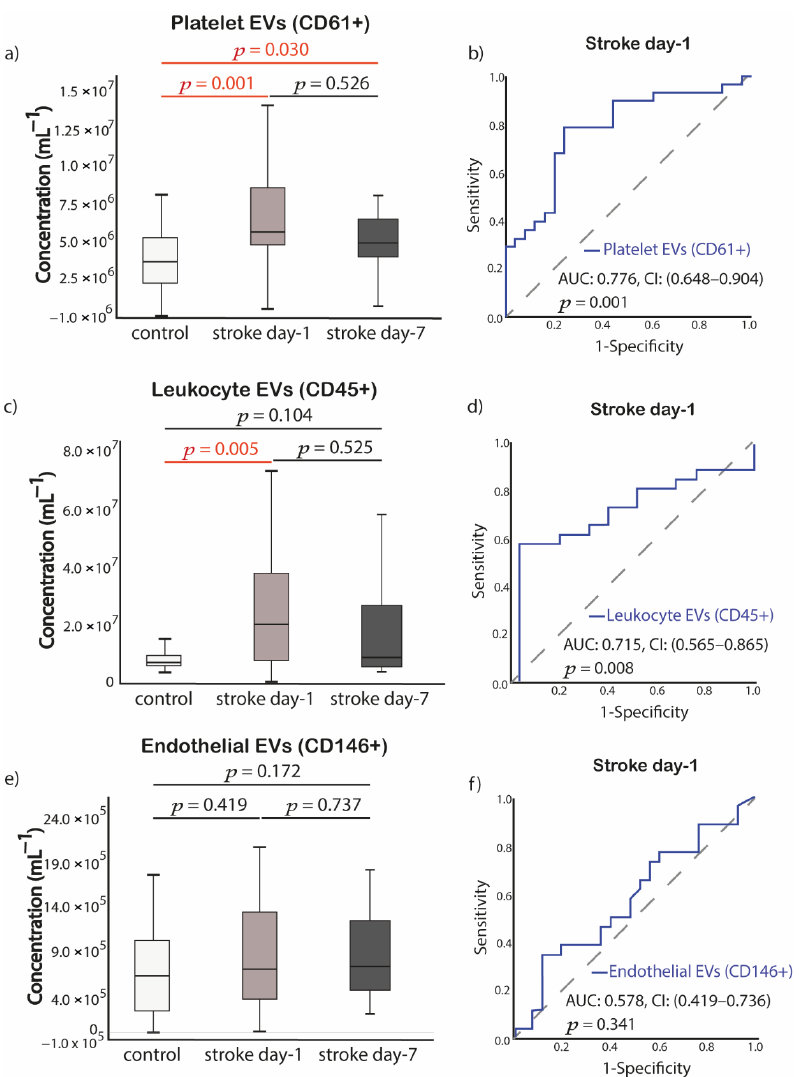
Figure 5. Alterations of EVs concentrations among the groups and diagnostic value of EVs determined by ROC curve analysis. ( a ) Platelet-EVs (CD61+); ( b ) ROC analysis of platelet-EVs (CD61+) from stroke day-1; ( c ) Leukocyte-EVs (CD45+); ( d ) ROC analysis of leukocyte-EVs (CD45+) from stroke day-1; ( e ) Endothelial EVs (CD146+); ( f ) ROC analysis of endothelial EVs (CD146+) from stroke day-1. p value was calculated with Mann-Whitney U or Wilcoxon test, appropriately (Control samples n = 35, acute stroke day-1 samples n = 28 and stroke day-7 samples n = 20). Abbreviations: EVs, extracellular vesicles; p , value; AUC, area under the curve; CI, confidence interval; ROC, Receiver operating characteristic.